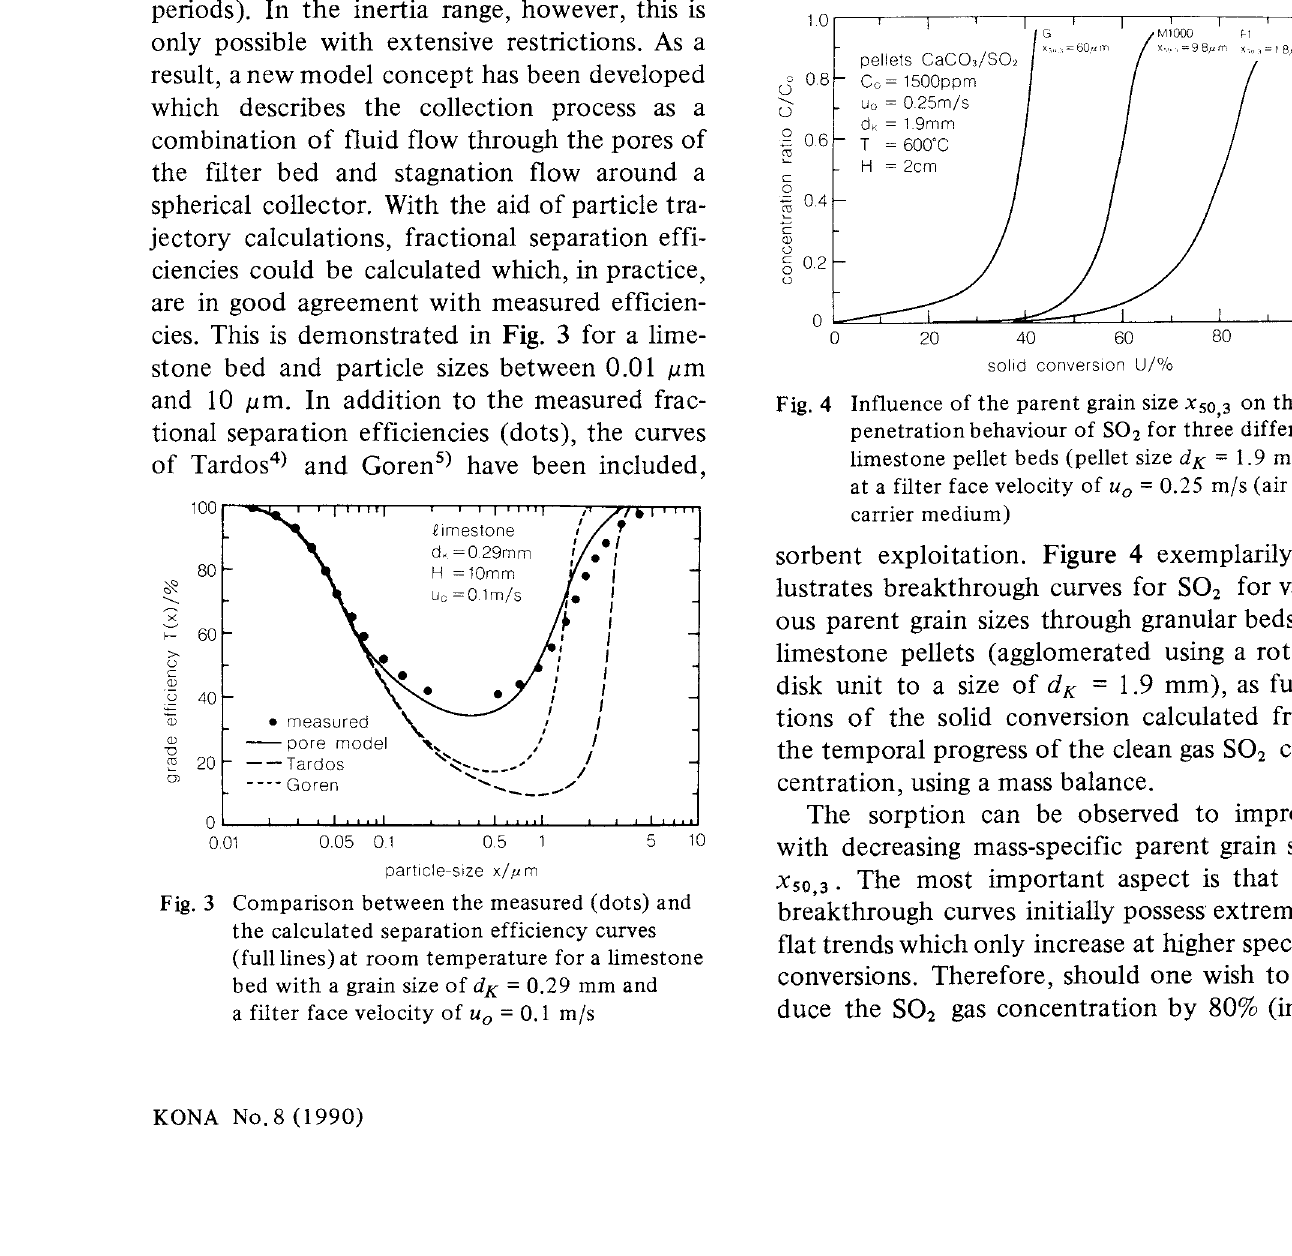
MlOOO f-1 x ·· ,g B,urr x-,, , ""1 Bu'll